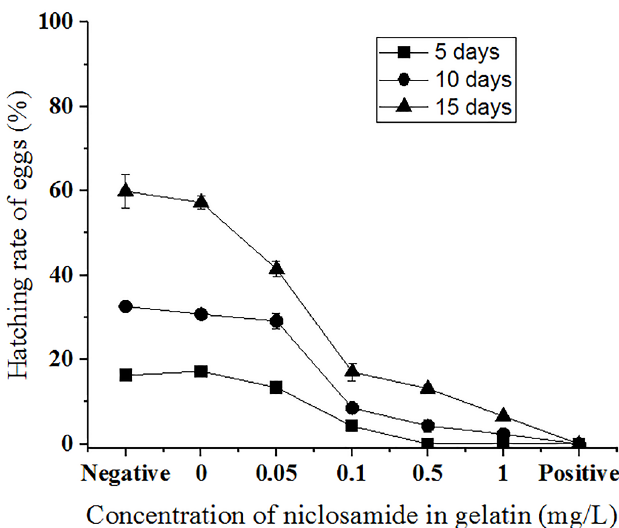
Figure 6. Hatching rate (%) of P. canaliculata eggs treated with different concentrations of niclosa- mide in gelatin for 5 days (square), 10 days (circle), and 15 days (triangle) under 1 mg/L niclosa- mide in 1.5% ( w / v ) gelatin. Negative: P. canaliculata eggs hatched in a culture dish without the gel- atin or drug. Positive: eggs hatched in a culture dish with 0.1 mg/L niclosamide